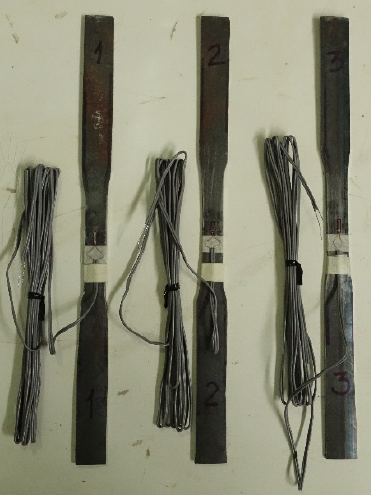
Figure 7. Specimens with strain gauges for testing the elastic modulus.